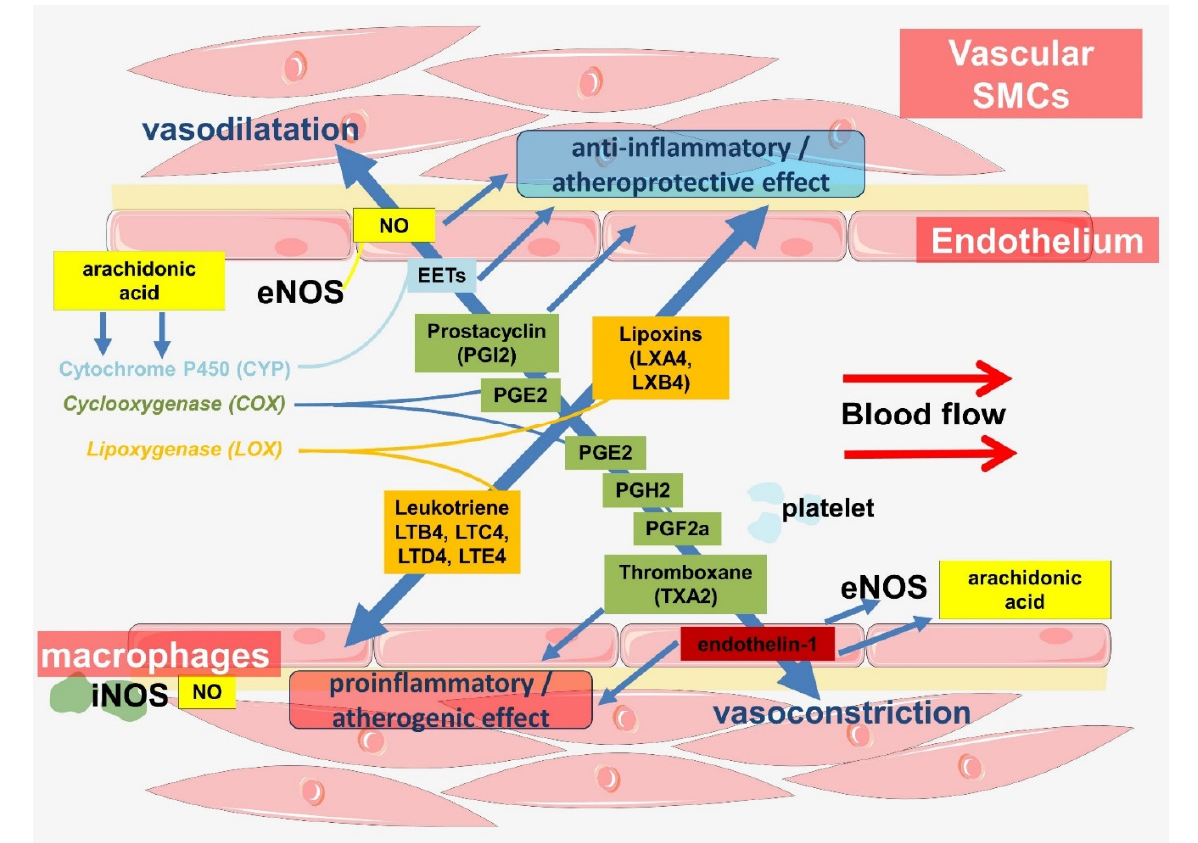
Figure 4. Cross-links in the regulation of hemodynamics and innate immunity involving endothelial